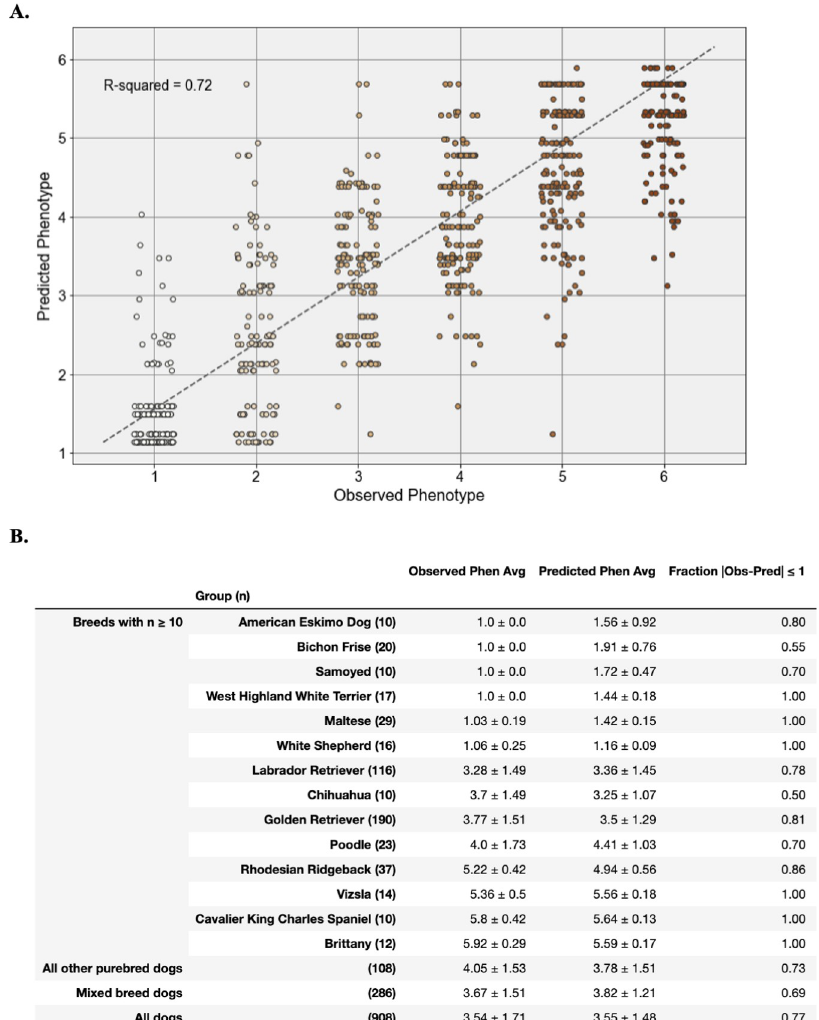
Fig 5. Performance of the best fit multivariate linear regression model for pheomelanin intensity phenotypes in validation cohort. A. Strip plot of observed versus predicted phenotypes for all dogs in the validation dataset using the predictive model shown in Table 3. The adjusted R-squared value is shown in the top right hand corner. Each point represents a single dog, colored according to its observed six point phenotype. B. Performance of the multivariate linear regression model within and across breeds. For each row, observed and predicted phenotype averages are shown ± their standard deviation. To assess model prediction accuracy in each breed or group, each row shows the fraction of dogs with a predicted phenotype value within one point of their observed phenotype (on the six point phenotype scale). p-value = 2.595 x 10 − 9 ) or the model with the best fit dominance encoding and no epistasis (Table 5B) (likelihood ratio test p-value = 5.104 x 10 − 6 ). We applied the reduced best fit predic- tive model to the 908 dogs in the validation sample and found that it was able to explain 72% (adjusted R-squared = 0.7211) of variation in coat pheomelanin intensity across all dogs (Fig 5A).